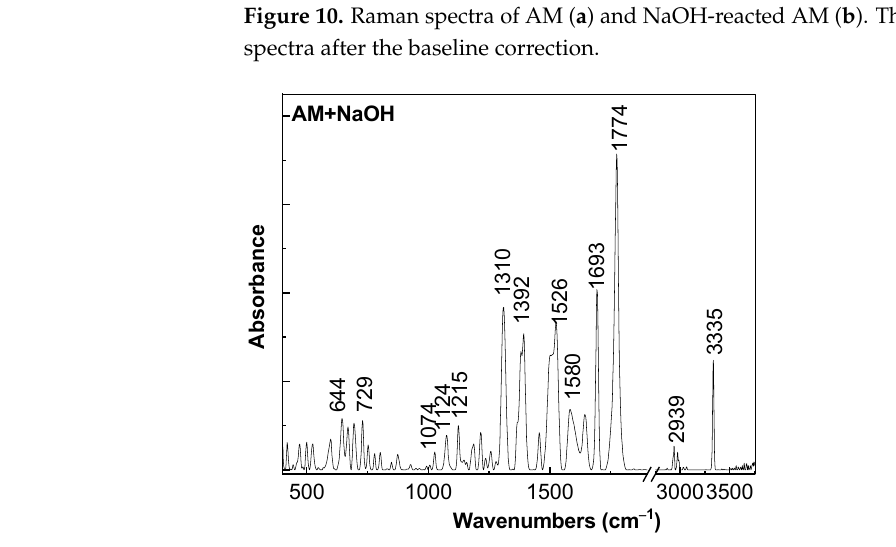
Figure 11. The IR spectrum of NaOH-reacted AM.